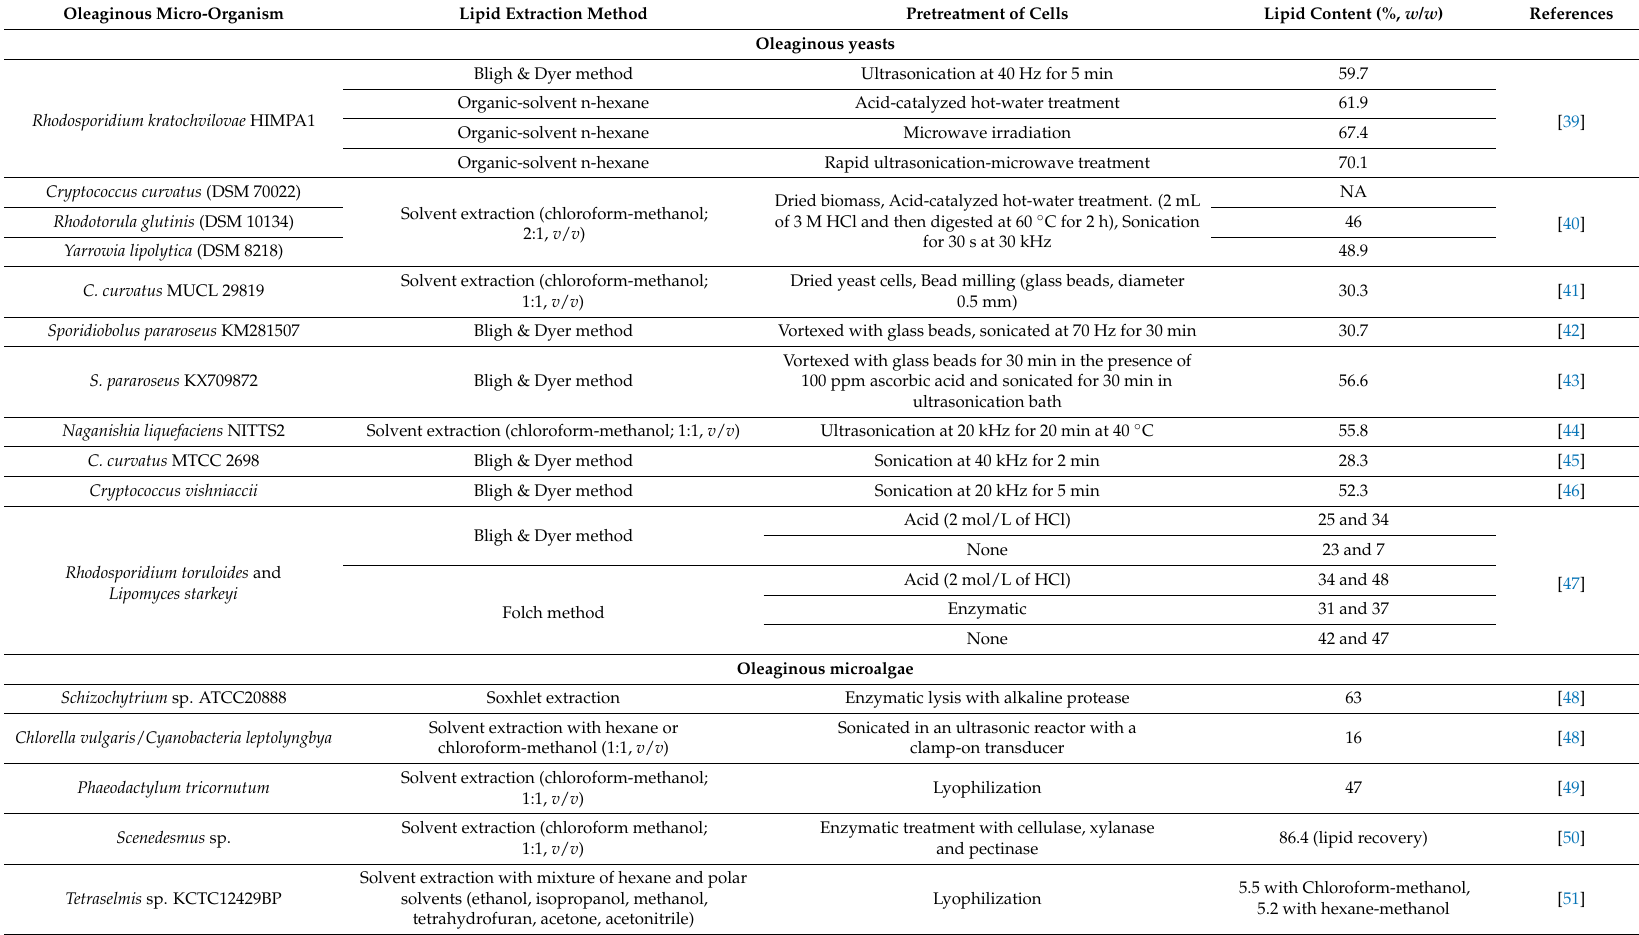
Table 1. Comparison of various pretreatment methods for lipid extraction from oleaginous microbial